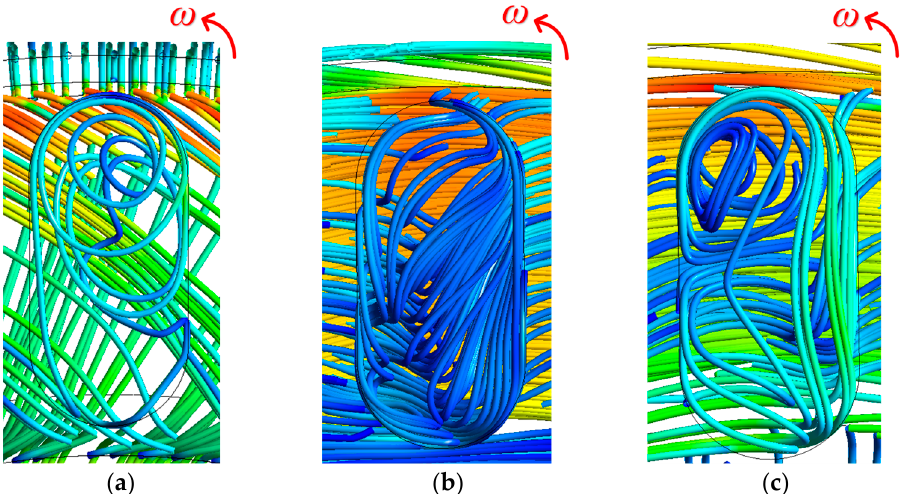
Figure 13. Three-dimensional streamlines of the first-stage liquid-sealing impeller: ( a ) leakage state; ( b ) isobaric sealing state and ( c ) negative pressure sealing state.